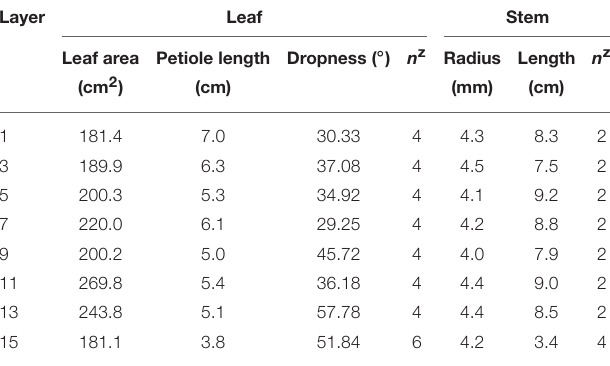
TABLE 1 | Structural characteristics of leaves and stems by layer. Layer Leaf